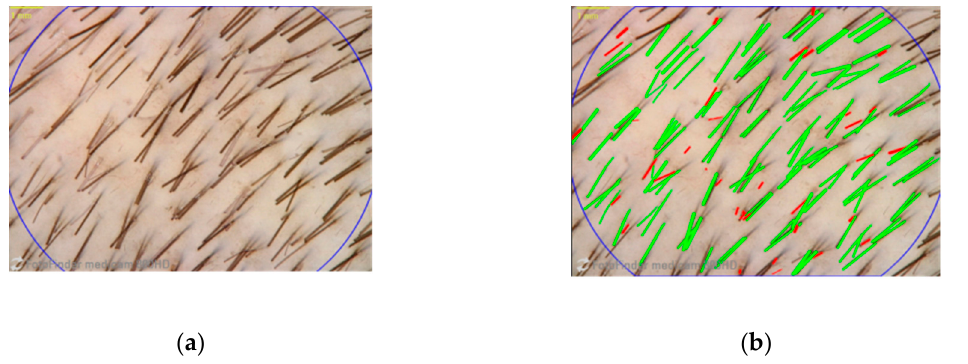
Figure 1. ( a ) Test area three days after hair clipping.; ( b ) Test area three days after hair clipping and analyzed by TrichoScale software. Hairs highlighted in green are defined as anagen.